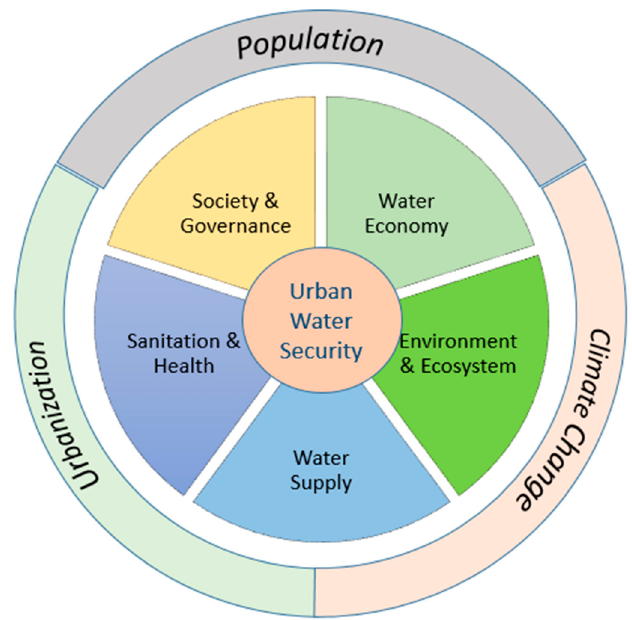
Figure 1. Population, urbanization, and climate change are the major drivers of water (in)security; urban water security index (UWSI) dimensions, their corresponding indicators and variables measure the pressures, state, impacts and responses associated with water security. (Source: Authors).